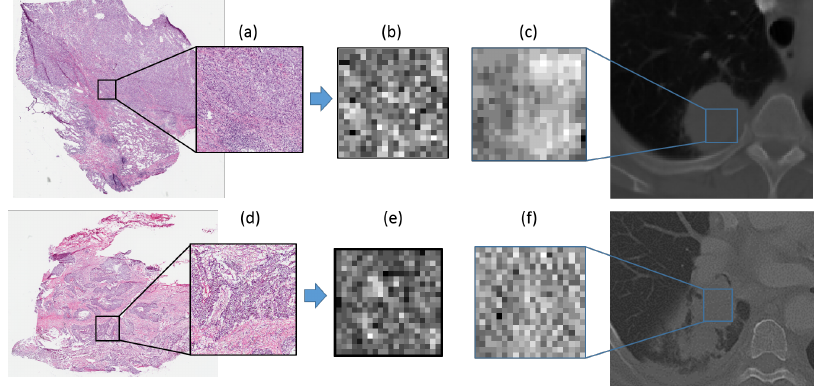
Figure 1. Estimating cellular density on histopathology slides: ( a , d ) illustrate a patch from each WSI, ( b , e ) show the associated cell density map, and ( c , f ) depict a corresponding tumor patch from CT. The top row shows a representative ADC while the second corresponds to a SCC study.